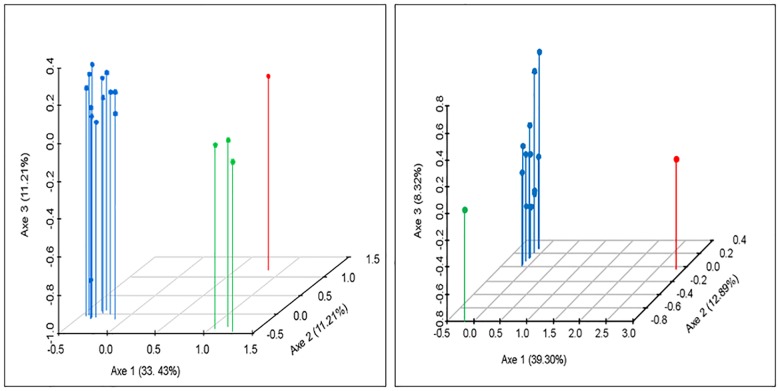
Graphic representation of the factorial correspondence analysis results.a) Factorial correspondence analysis results involving the 17 cattle breed populations; and b) factorial correspondence analysis results without Bos indicus breeds. In a) Red: ZEBU; Green: GYR. BRH. NEL; Blue: BON, HV. EC, RGA. BC, MA, HER, JER, BWS, CHAR, FRI, SIM, MAC; in b) Red: MAC; Green: HER; Blue: BON, HV, EC, RGA, BC, MA, JER, BWS, CHAR, FRI, SIM.